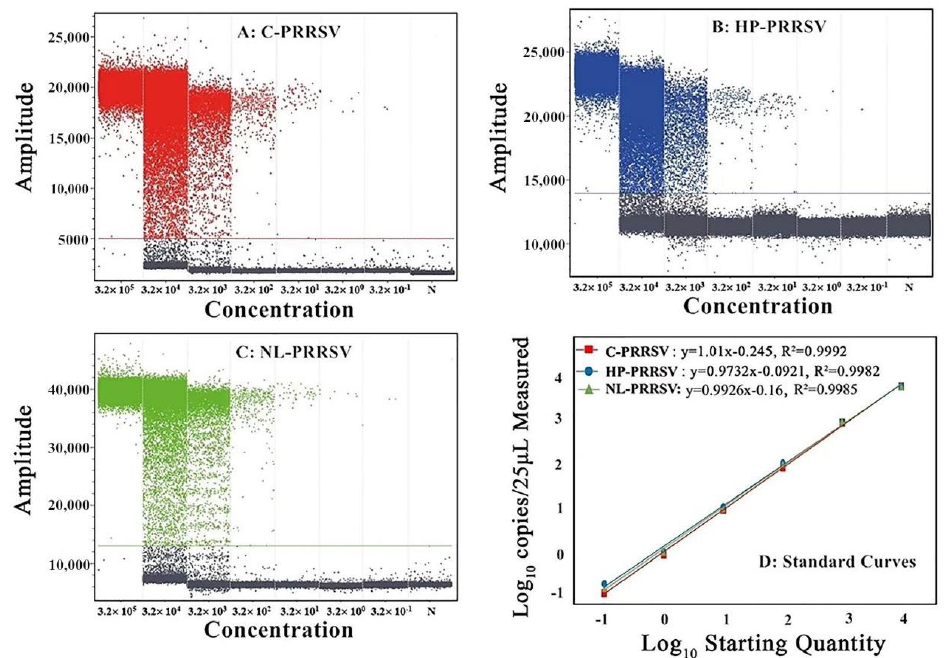
coefficient (R 2 ) were 1.01 and 0.9992 for C-PRRSV, 0.9732 and 0.9982 for HP-PRRSV, and 0.9926 and 0.9985 for NL-PRRSV, respectively (Figure 3D).